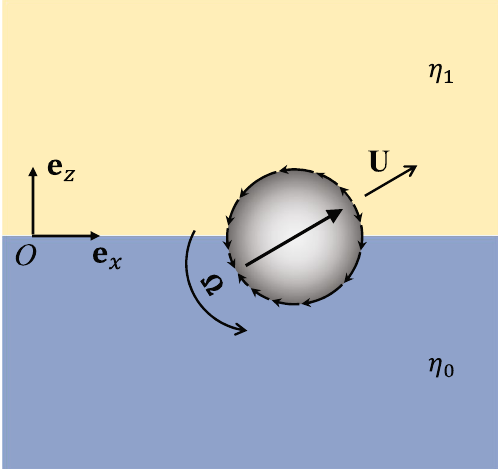
Figure 2. Schematic showing an active particle passing through sharp viscosity gradient and the associated coordinate system. The interface separates fluid of different viscosities η 0 and η 1 . The particle radius is a and its translational and rotational velocities are U , (cid:31) ,